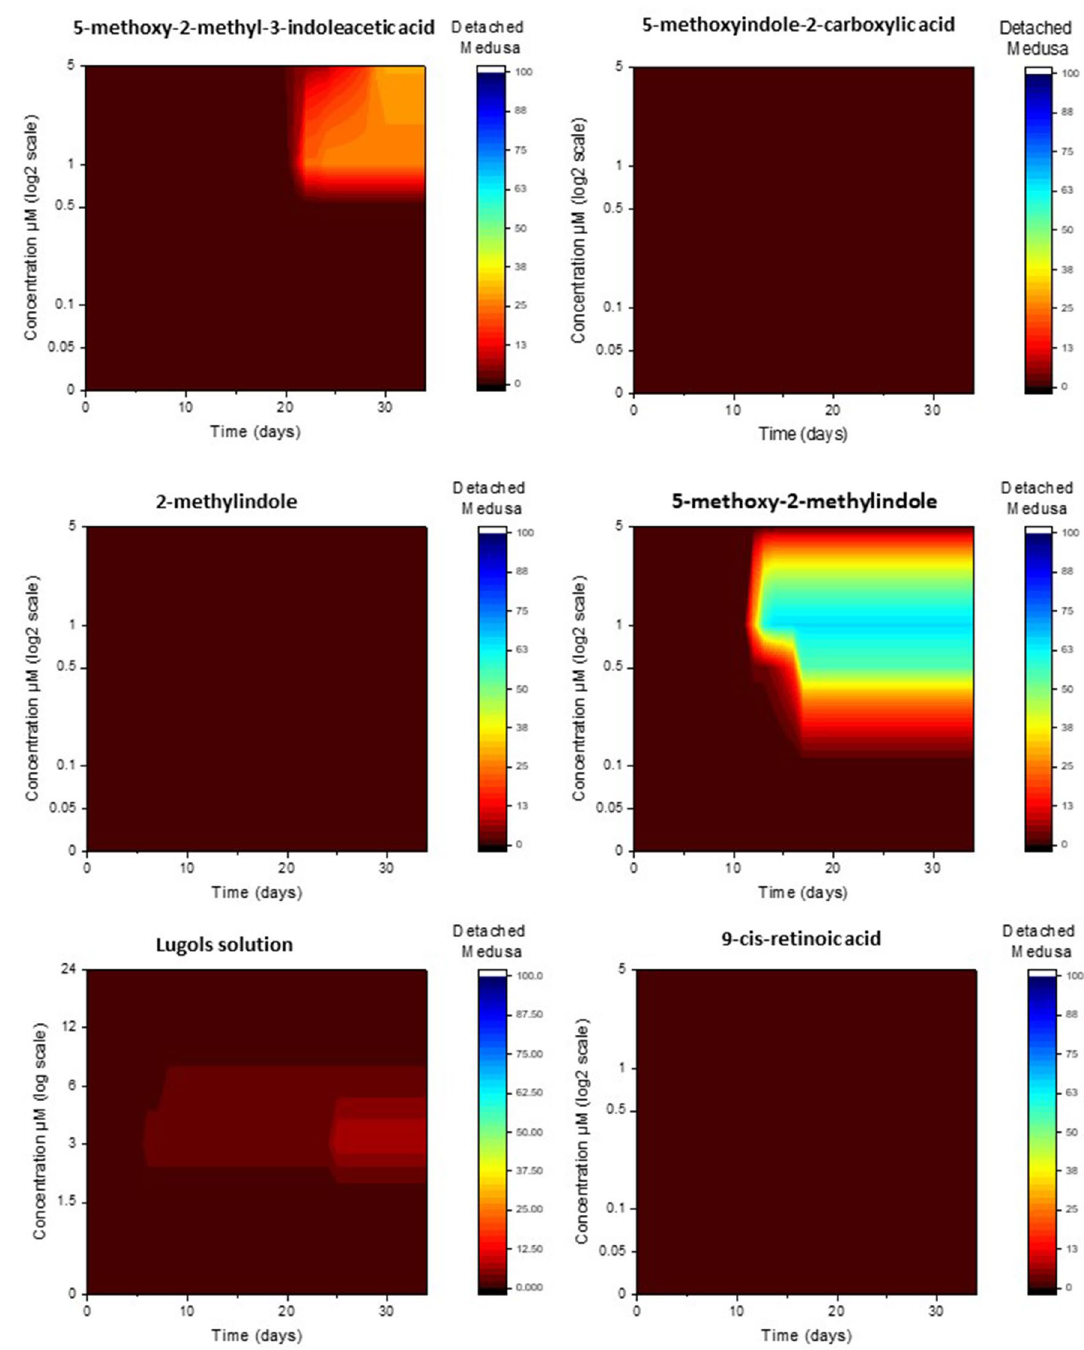
Figure 2. The cumulative percentage of detached medusa from Carukia barnesi polyps after exposure to six chemical treatments, over time in response to chemical